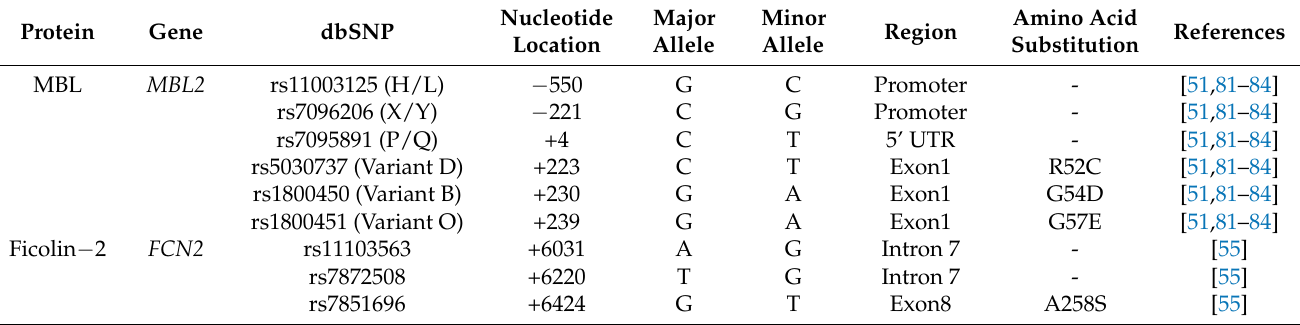
Table 2. Single-nucleotide polymorphisms in the MBL2 and FCN2 genes associated with dengue disease. Protein Gene dbSNP MBL